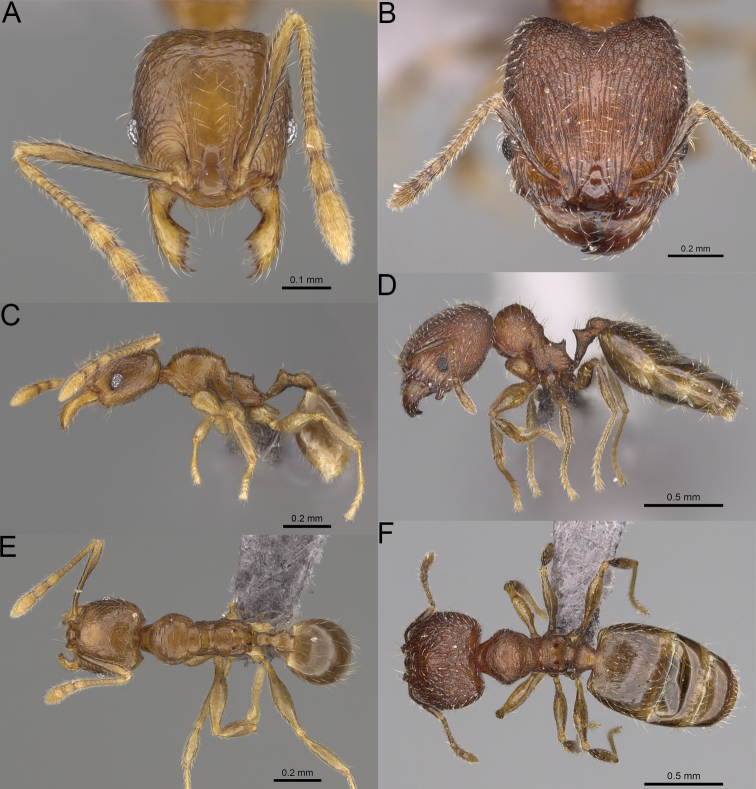
Pheidole
mikros sp. nov., full-face view (A), profile (C), and dorsal view (E) of paratype minor worker (CASENT0261101) and full-face view (B), profile (D), and dorsal view (F) of holotype major worker (CASENT0923271).